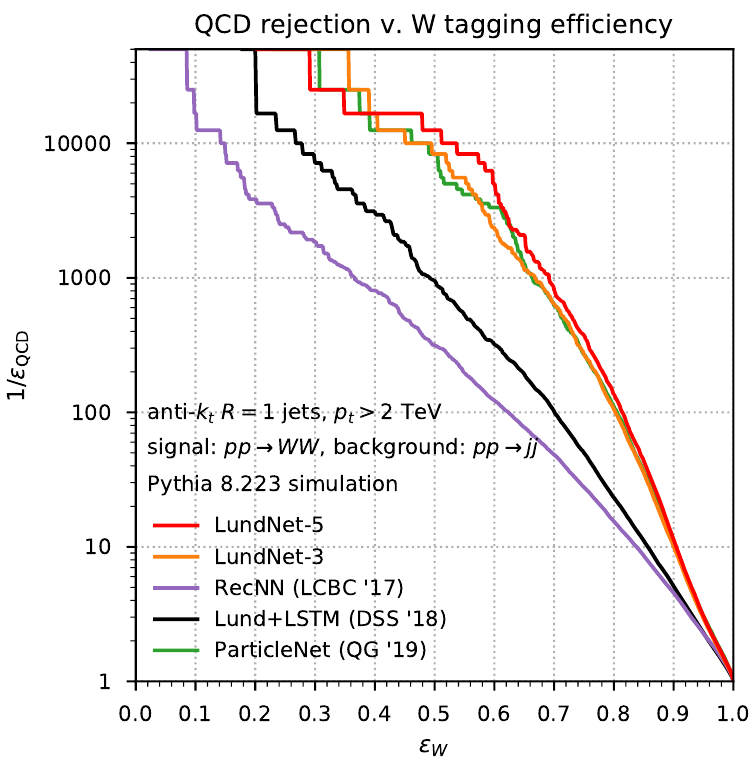
Figure 5 . Background rejection 1 /(cid:15) QCD versus signal efficiency (cid:15) W for W jet tagging with trans- verse momentum p 2 t >